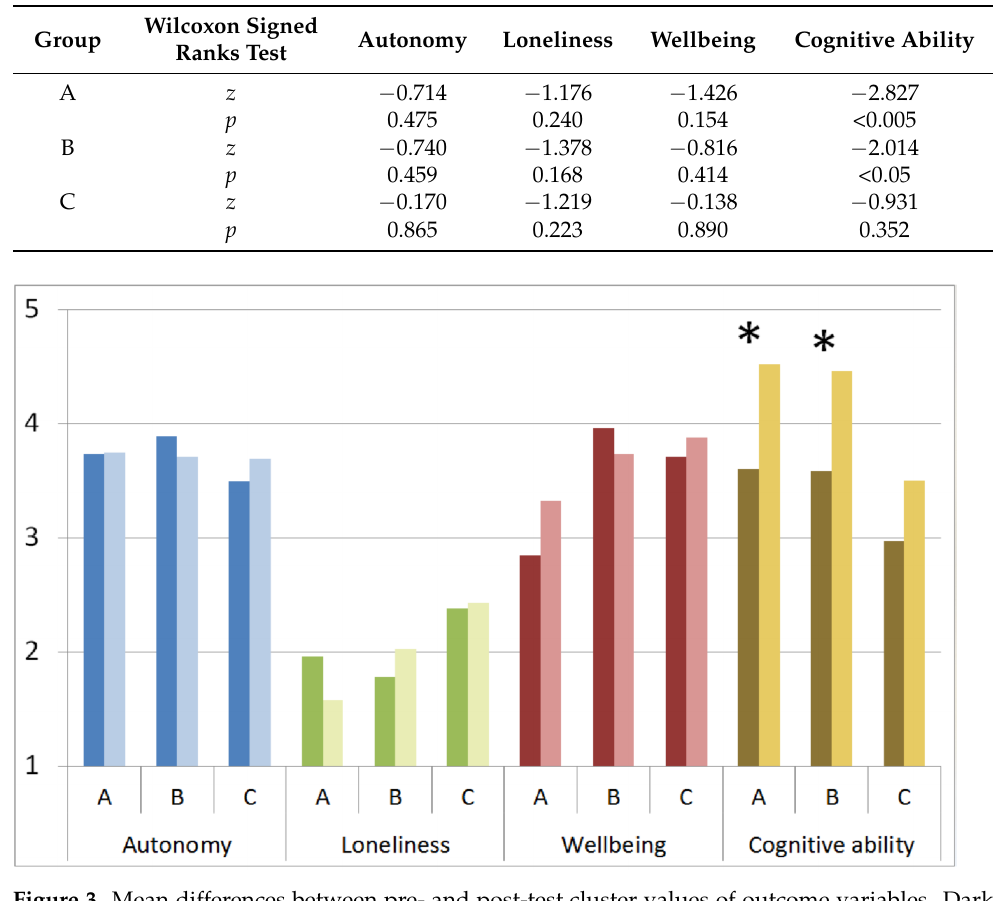
Figure 3. Mean differences between pre- and post-test cluster values of outcome variables. Dark colors: pre-test values, light colors: post-test values. A = home assistance service, B = retirement home, C = control group; Asterisks indicate significant